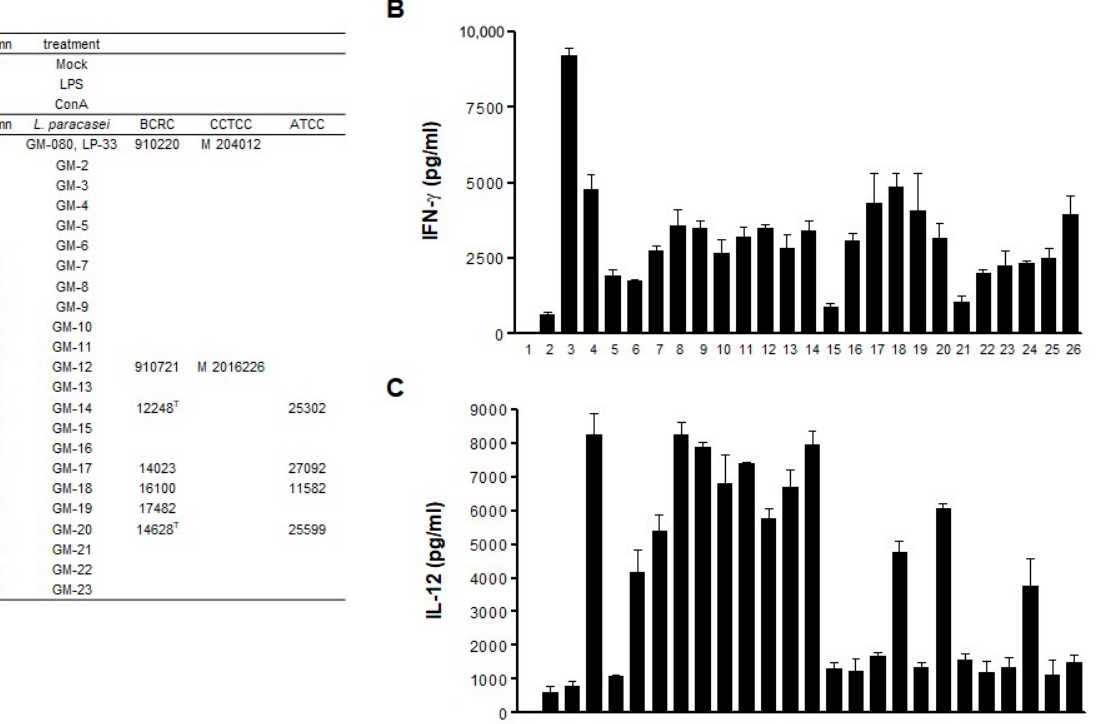
Figure 1. Th1 cytokine induction by GM-080 in mouse splenocytes. ( A ) List of L. paracasei strains used for coculture with mouse splenocytes. ( B , C ) Different strains of viable L. paracasei were used to coculture with mouse splenocytes at MOI = 10 for 48 h. The presence of IFN- γ ( B ) and IL-12 ( C ) in the culture supernatants was determined using commercial ELISA kits. LPS (1 µg/mL) or ConA (2 µg/mL) was used as the positive control.